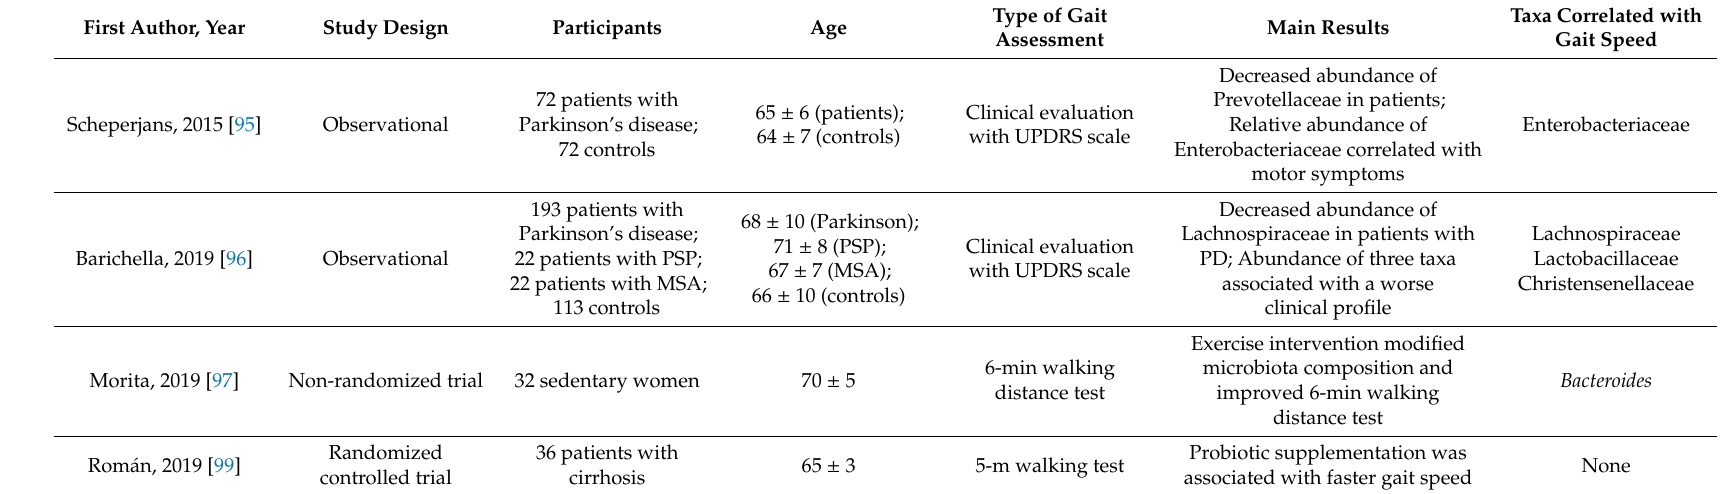
Table 1. Overview of the main human studies that investigated the association between fecal microbiota composition and gait